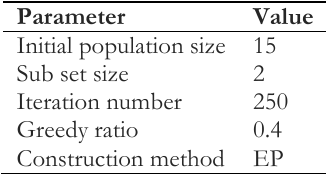
Table 2. BPS value.